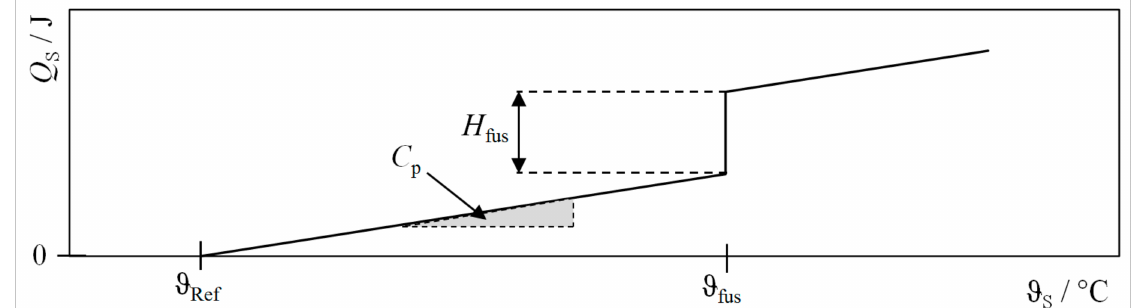
Figure 1. Context of thermophysical properties enthalpy of fusion H fus , heat capacity C p ( ϑ ) and melting temperature ϑ fus with course of sample heat Q S over sample temperature ϑ S referred to reference temperature ϑ Ref .